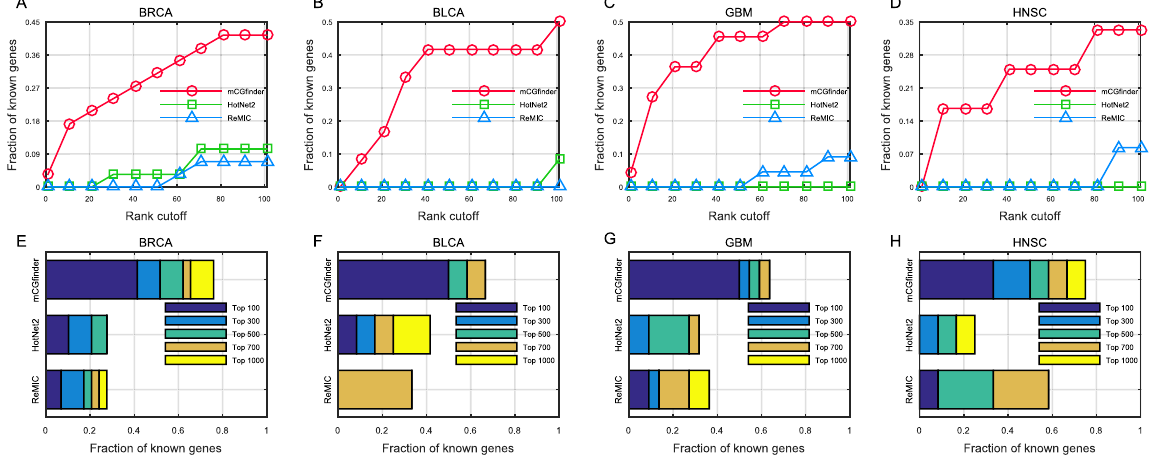
Figure 3. Rank cutoff curves of top 100 candidates in mCGfinder (red line with circle markers), HotNet2 (green line with square markers) and ReMIC (blue line with triangle markers) results, describing the relation between various cutoffs and the fraction of known CGC cancer genes ranked above this cutoff in BRCA ( A ), BLCA ( B ), GBM ( C ) and HNSC ( D ). Cumulative fractions of known CGC cancer genes annotated by CGC within the top 100, 300, 500, 700 and 1000 genes in BRCA ( E ), BLCA ( F ), GBM ( G ) and HNSC ( H ). Results from all the assessments indicate the generally improved performance of mCGfinder over the competing